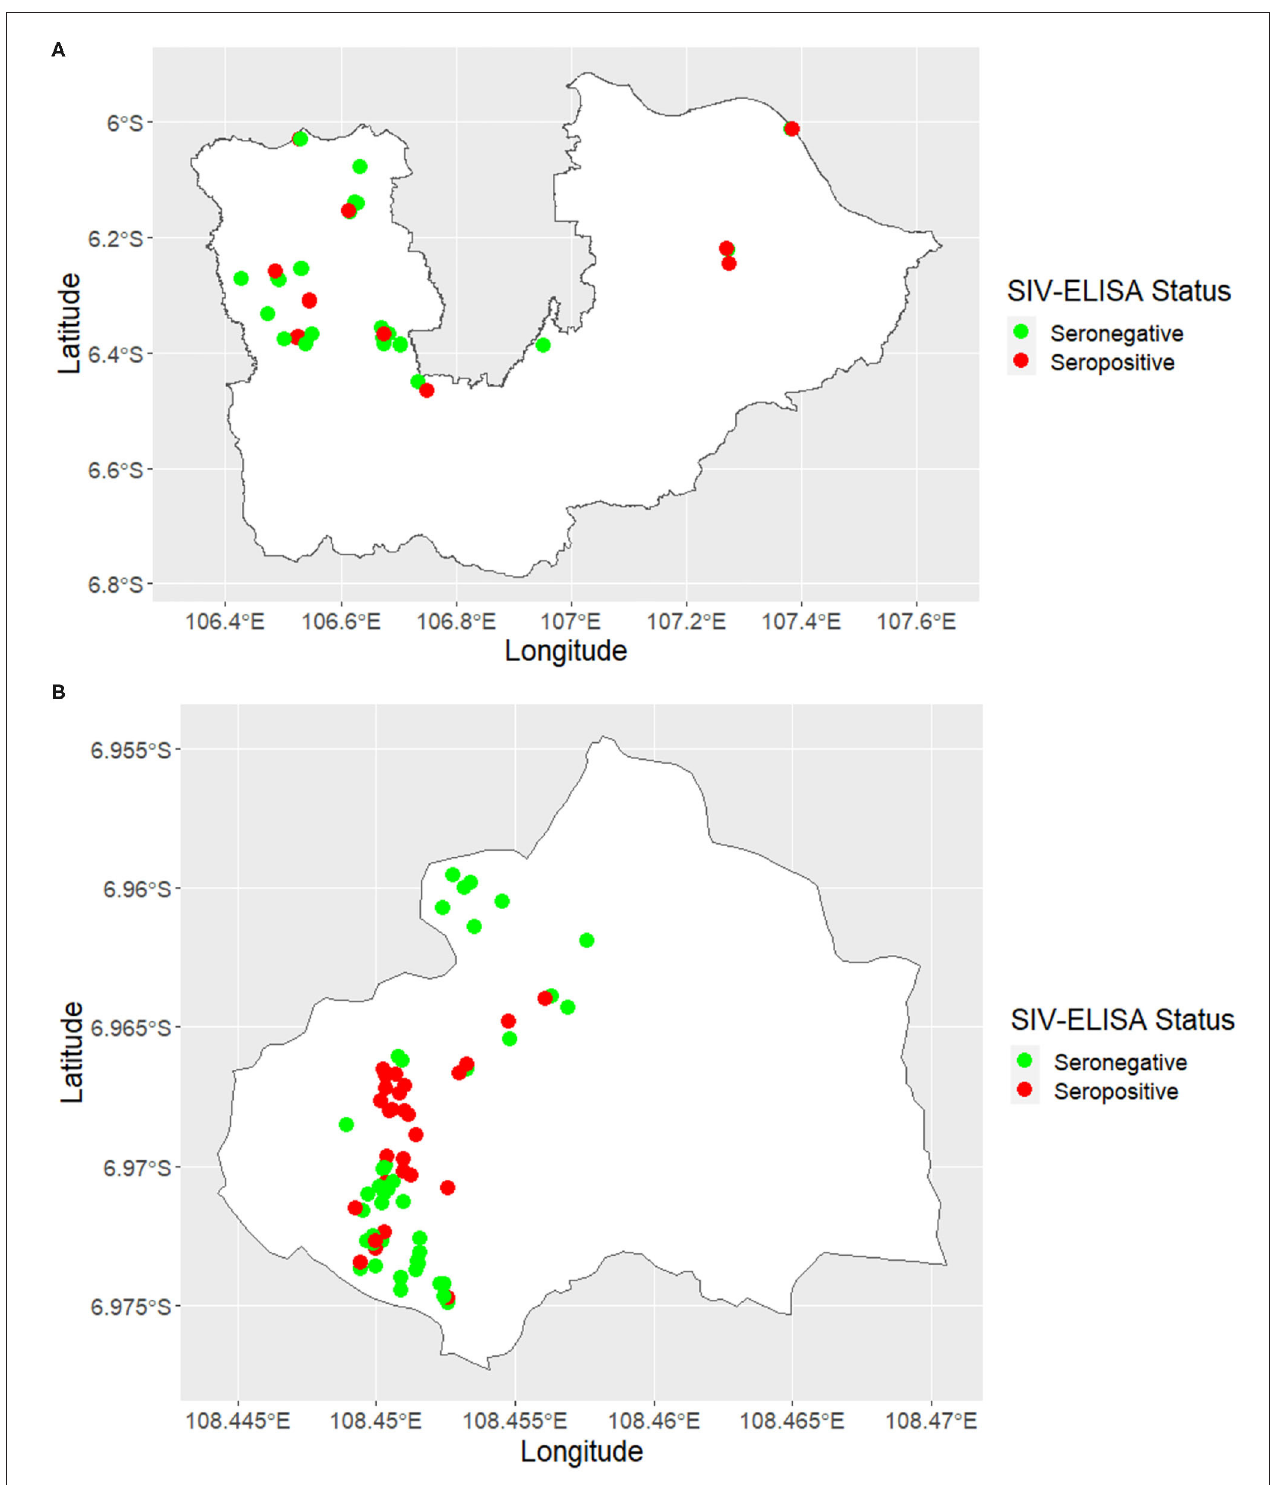
FIGURE 2 | Maps showing the location of swine influenza farm status classified by serological-test results in (A) Tangerang City, Tangerang, Bogor, Bekasi, and Karawang and (B) Kuningan.